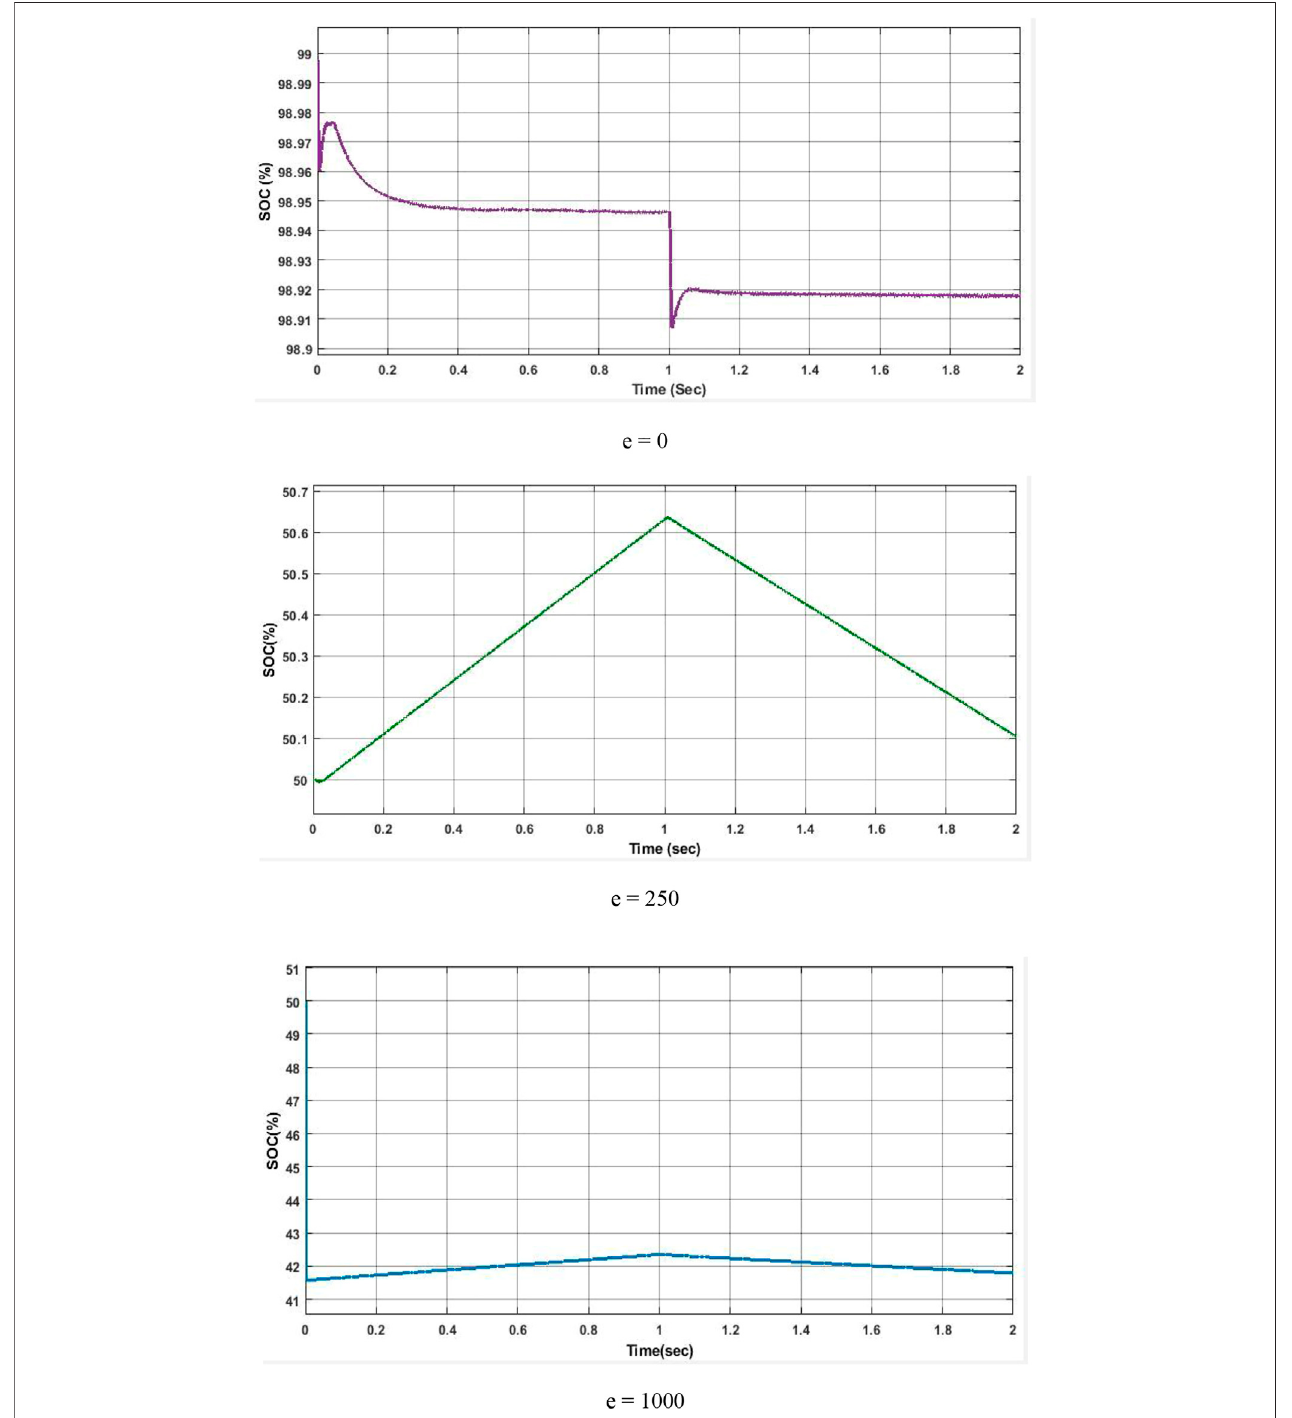
FIGURE 8 | Impact of the weight factor value, that is, e (cid:1) 0.250, 1,000 on the battery SOC behavior.